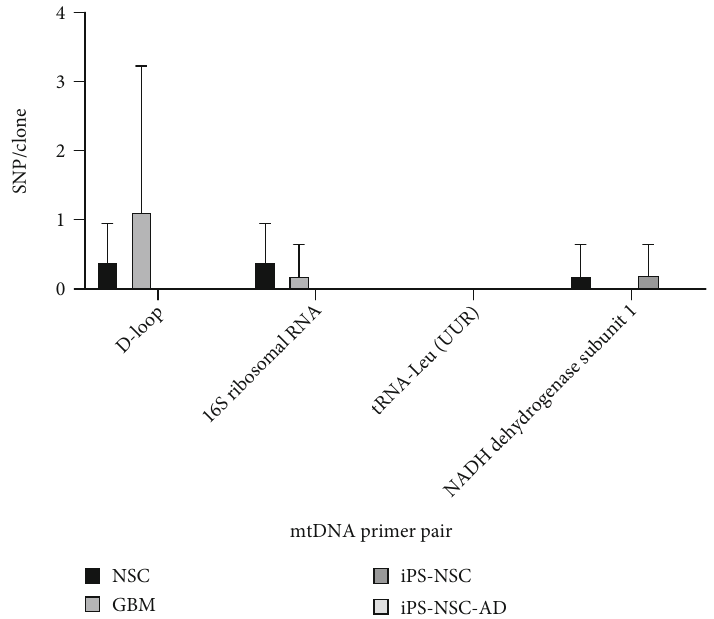
Figure 2: The number of the SNPs in clones obtained from the primer pair sets for D-loop, 16S ribosomal RNA, tRNA-Leu (UUR), and NADH dehydrogenase subunit 1 of mtDNA associated with exosomes released by neural stem cells (NSC), glioblastoma multiforme (GBM), control subject iPS-derived NSC (iPS-NSC), and AD subject iPS cells (iPS-NSC-AD). The numbers of SNPs in each group ( n = 5 ) are presented as mean ± SD . Two-way ANOVA followed by Tukey ’ s multiple comparison post hoc analysis was performed, and there was no signi fi cant di ff erence among the groups ( P > 0 : 05